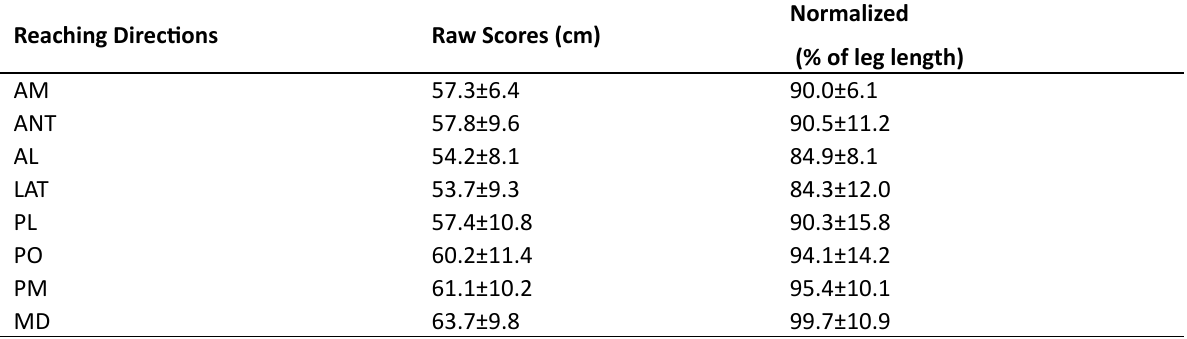
Table 1. Descriptive statistics for dependent variables Reaching Directions